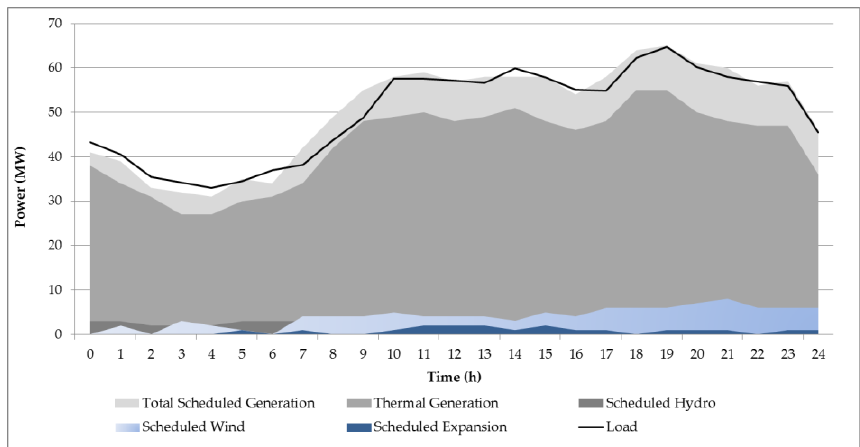
Figure 6. Scheduled diagram of all generation under study.